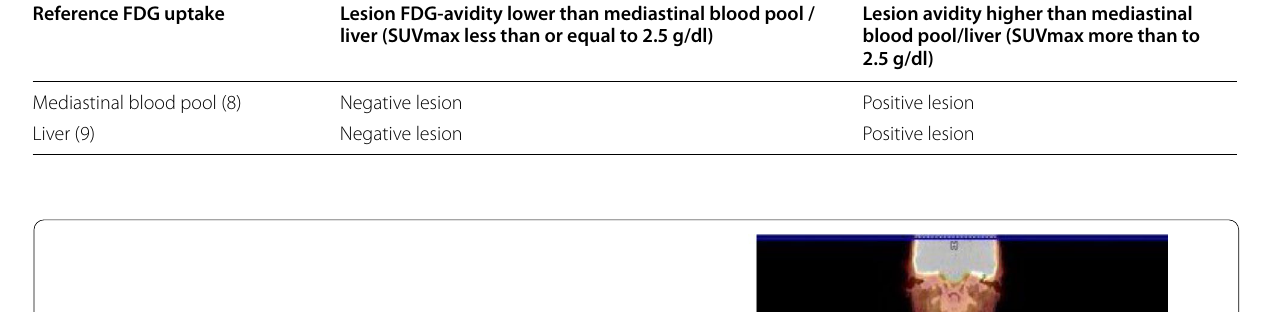
to mid-thigh using the following protocol: PET images acquired in list mode acquisition, 2 min per bed posi- tion. The CT scan was performed first before PET, and